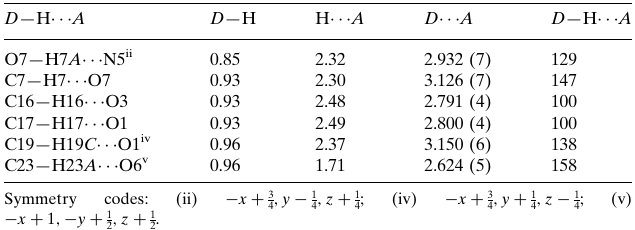
Hydrogen-bond geometry (A˚ , (cid:5)